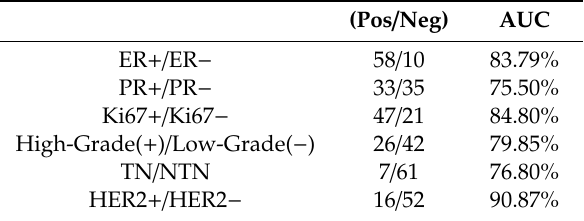
Figure 2. Area Under the Curve (AUC) of the Receiver Operating Characteristic (ROC) of the multivariable discriminant analysis model for each classification task. Table 3. Class size and AUC values resulting from six classification